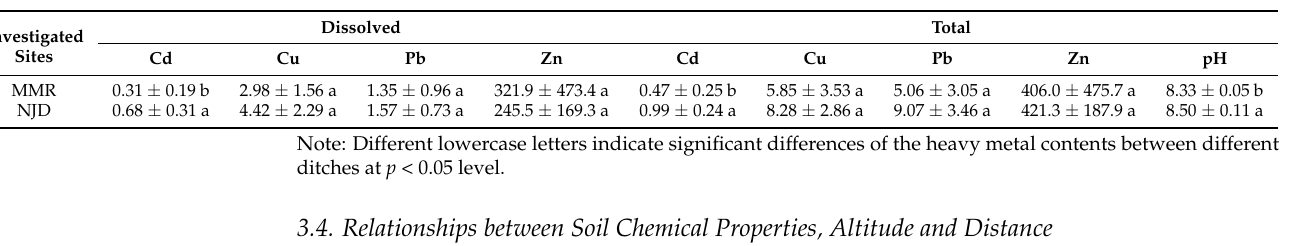
Table 3. Heavy metal contents of surface water in ditches ( µ g L − 1 ).